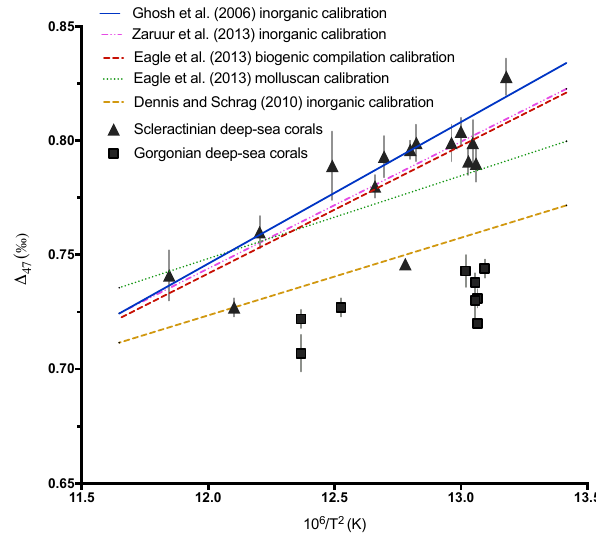
Figure 4. Scleractinian corals from this study and Thiagara- jan et al. (2011) are combined (slope: 0.0582 ± 0.008; intercept: 0.0452 ± 0.103; R 2 = 0.81) and, along with gorgonian deep-sea corals, are compared to other reported calibration